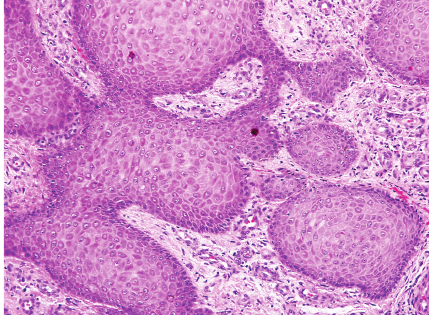
Figure 5: Pseudoepitheliomatous hyperplasia: higher magnification view showing reactive-appearing squamous downgrowths with no significant cytologic atypia. The dermis shows mild chronic inflammation and granulation tissue formation (H&E, ×